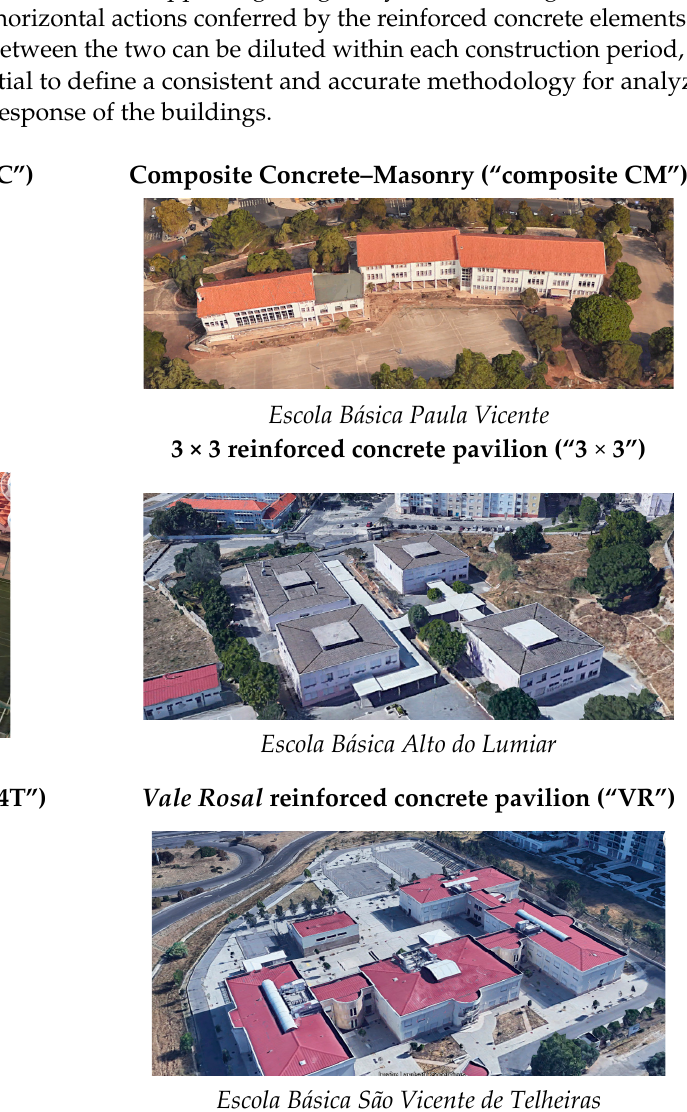
Figure 2. Examples of the identified structural typologies of the school buildings. In terms of what concerns the reinforced concrete buildings, the 3 × 3, VR, and C24T typologies all correspond to framed reinforced concrete structures based on a modular system (possibly prefabricated). This system consists of regular frames with spans around 4.5 m. The number of frames in the two directions form different building configurations (e.g., three spans of 4.5 m in each direction of the 3 × 3 typology) and justify the definition of these three different typologies, thus facilitating the analysis and interpretation of results. Otherwise, typology “reinforced concrete structure” (RC) includes structures that do not fit into the aforementioned typified categories and, consequently, require an individualized analysis. Although these RC buildings are mostly frame structures, they are not based on modular, or typified, building